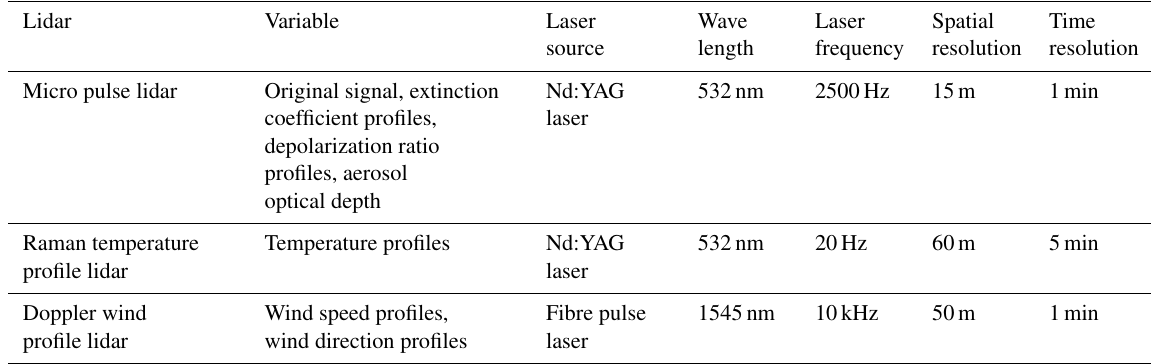
Figure 2. Setup of the multi-lidar system on the vehicle. Table 2. Detailed parameters for the three